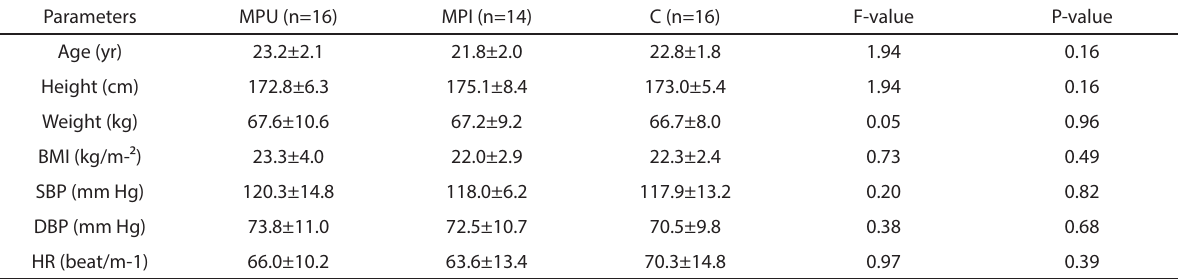
Table 1. Basic anthropometrical parameters of the three groups